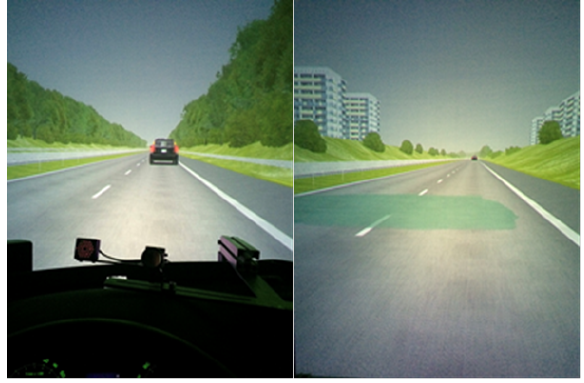
Figure 5. Highway simulation with dangerous